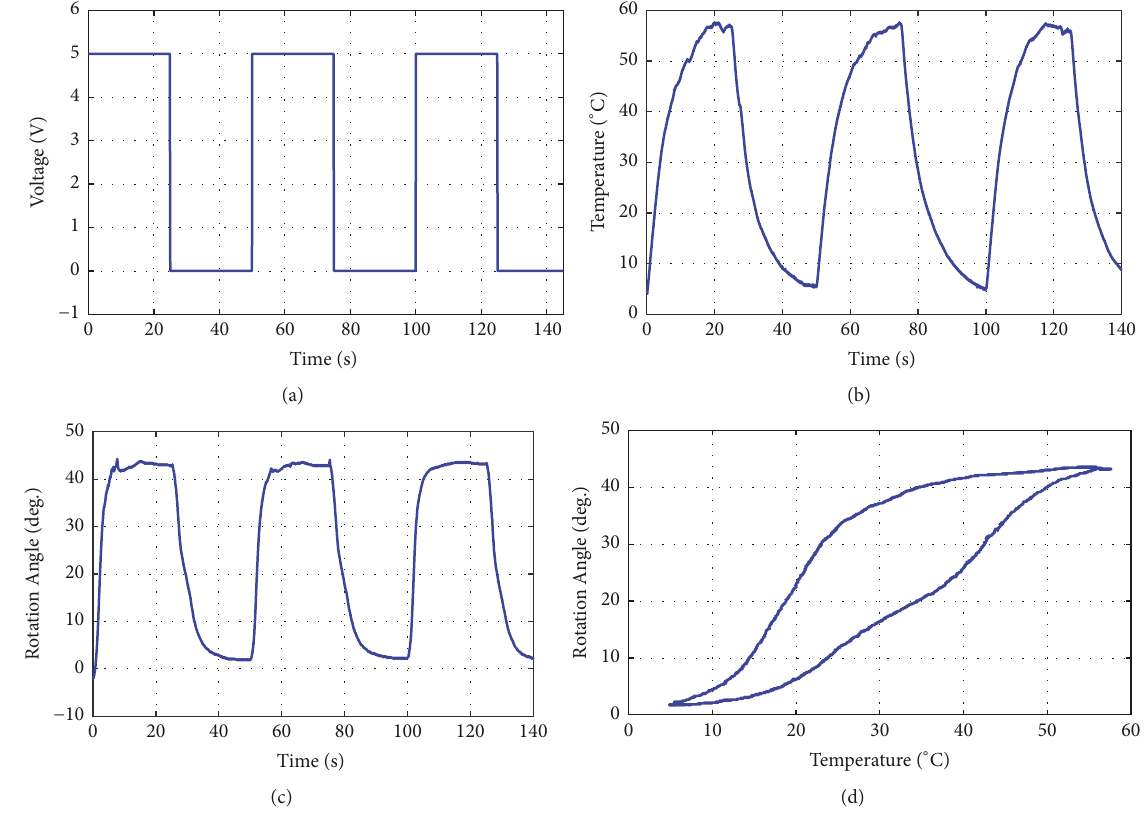
Figure 3: Input-output characteristics of the SMA-based compliant actuators under a fixed duty cycle (50%) 5v PWM signal operation with 50s signal cycle producing the temperature changing between 0 ∘ C and 60 ∘ C. (a) Input desired signal (voltage). (b) Input temperature. (c) Output rotation angle. (d) Hysteresis